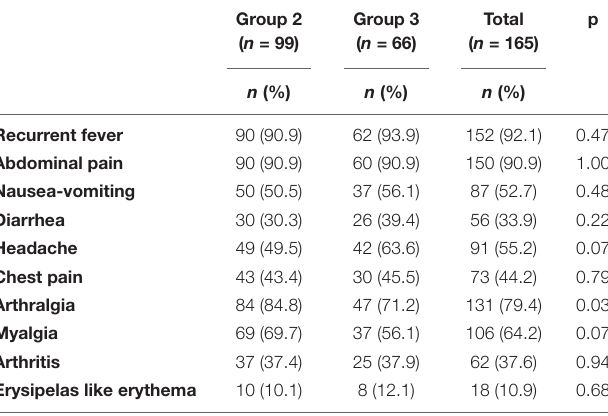
TABLE 2 | The main clinical symptoms in line with the autoinflammatory disease activity index (AIDAI) symptom scale and their comparison among the groups by the number of FMF